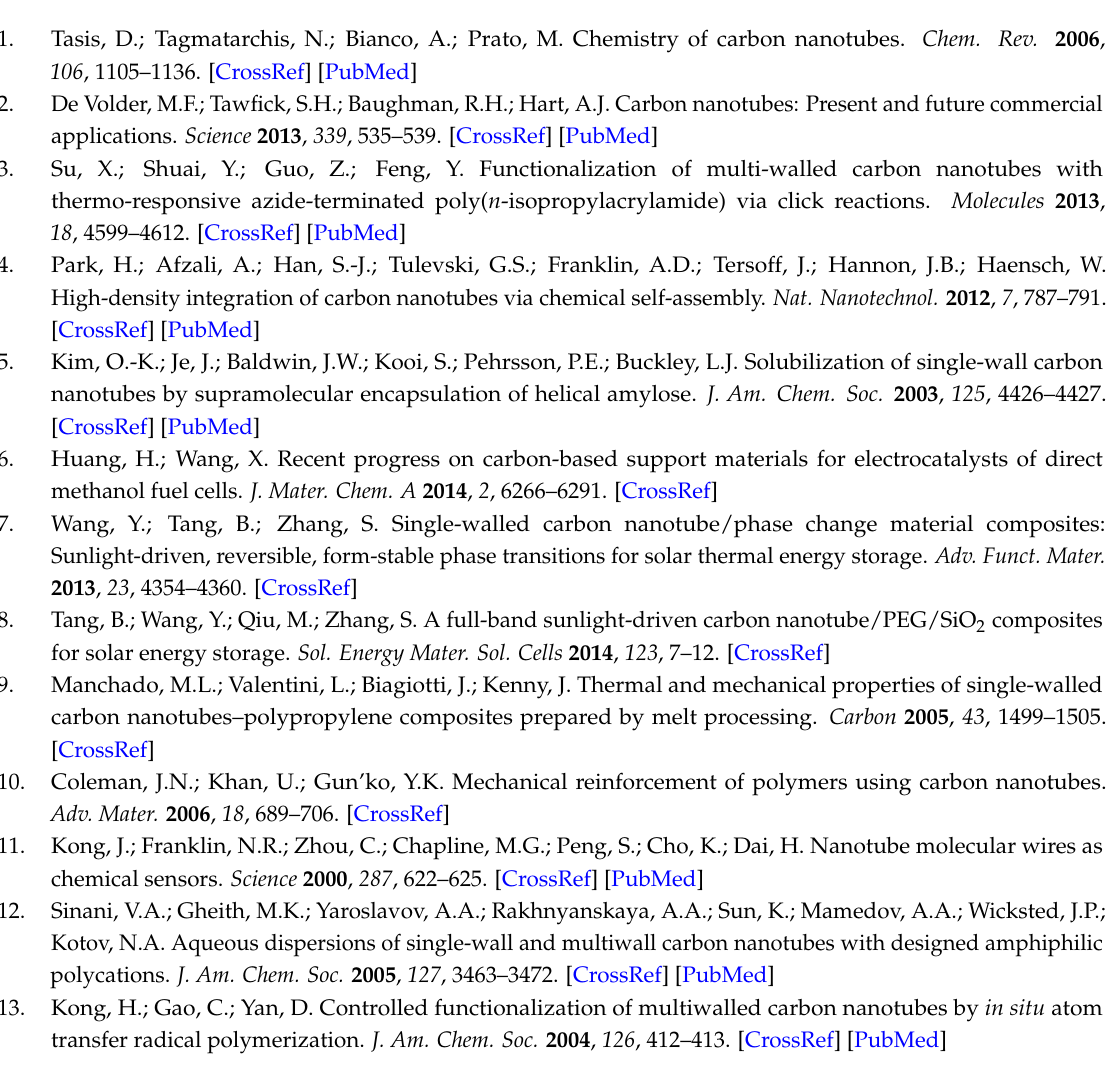
Figure S1: Photograph of dispersion behavior of MWCNTs: ( a ) crude MWCNTs; ( b ) modified MWCNTs; ( c ) homogeneous mixtures of PS emulsion doped with modified MWCNTs, Figure S2: UV-Vis spectra of the upper, middle, and bottom of the MWCNTs dispersion, Figure S3: ( a ) XPS spectra of crude and modified MWCNTs; ( b ) High-resolution XPS spectrum of S 2p core in modified MWCNTs, Figure S4: TGA weight loss curves of crude and modified MWCNTs, Figure S5: SEM image of pure PS film with hydrodynamic particle size of 317